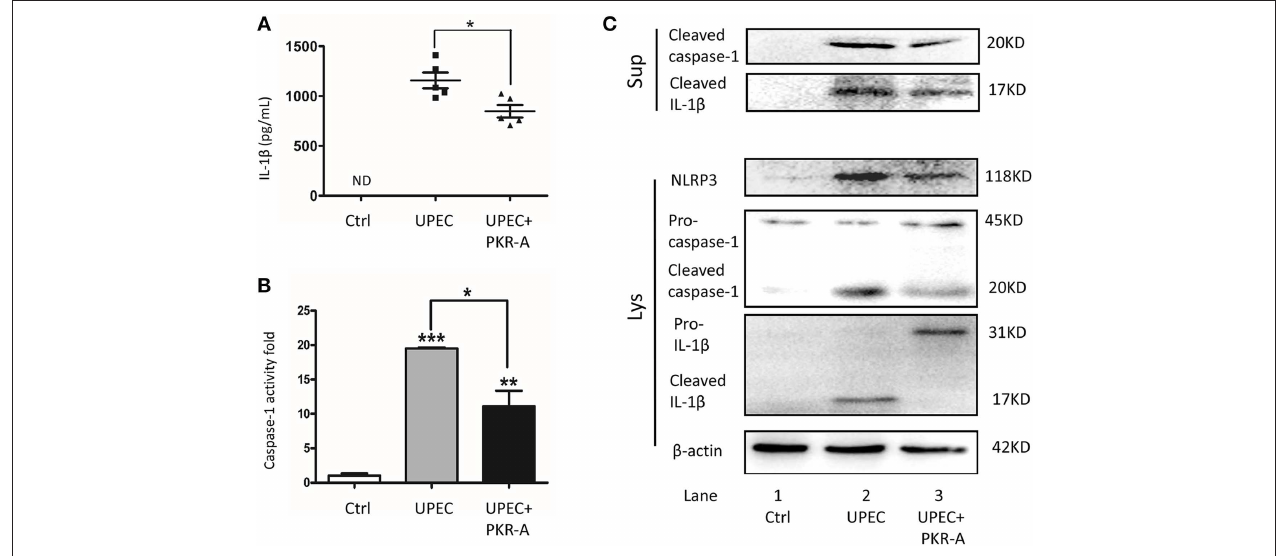
FIGURE 3 | Inhibition of PK2 results in decreased IL-1 β secretion. The UPEC-infected rats were injected with either 20 mg/kg of PKR-A or 5% DMSO into the testes every 2 days during the experiment. The sham operated rats received 5% DMSO as a control. TM were isolated from the three groups. The supernatants were collected after the isolated TM were further cultured for 2h. (A) IL-1 β secretion of the testicular interstitial fluid was analyzed by ELISA ( n = 5/group). (B) Whole-cell lysates were analyzed by caspase-1 activity assay to determine the cleaved-caspase-1 activity ( n = 3/group). (C) Concentrated supernatants were analyzed by western blot with antibodies against IL-1 β , caspase-1. Whole-cell lysates were analyzed by western blot with antibodies against IL-1 β , caspase-1, NLRP3, and β -actin. Ctrl, control; ND, no detected; Lys, cell lysates, Sup, supernatants. * P < 0.05, ** P < 0.01, *** P < 0.001 (one-way